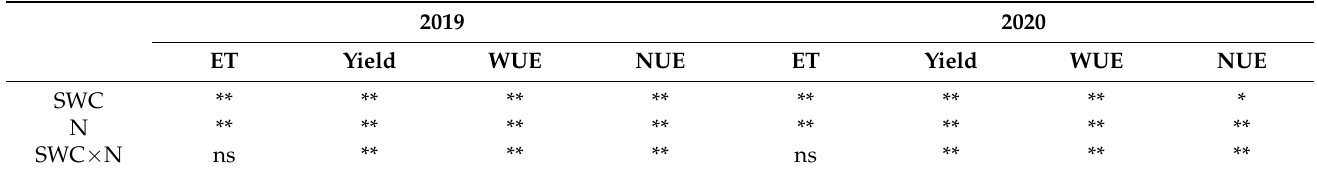
Table 4. Significant levels of various treatment effects on ET, yield, water, and nitrogen use efficiency.